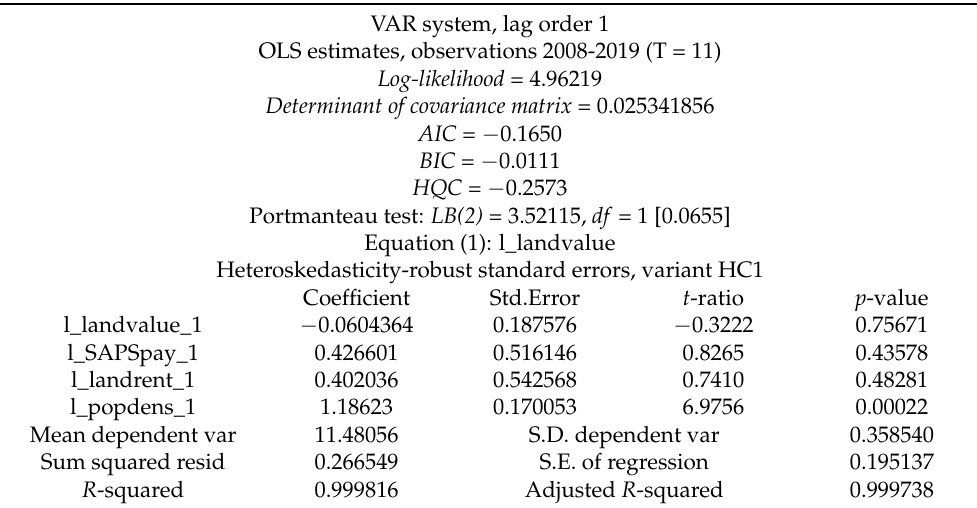
Table 6. Results of error correction